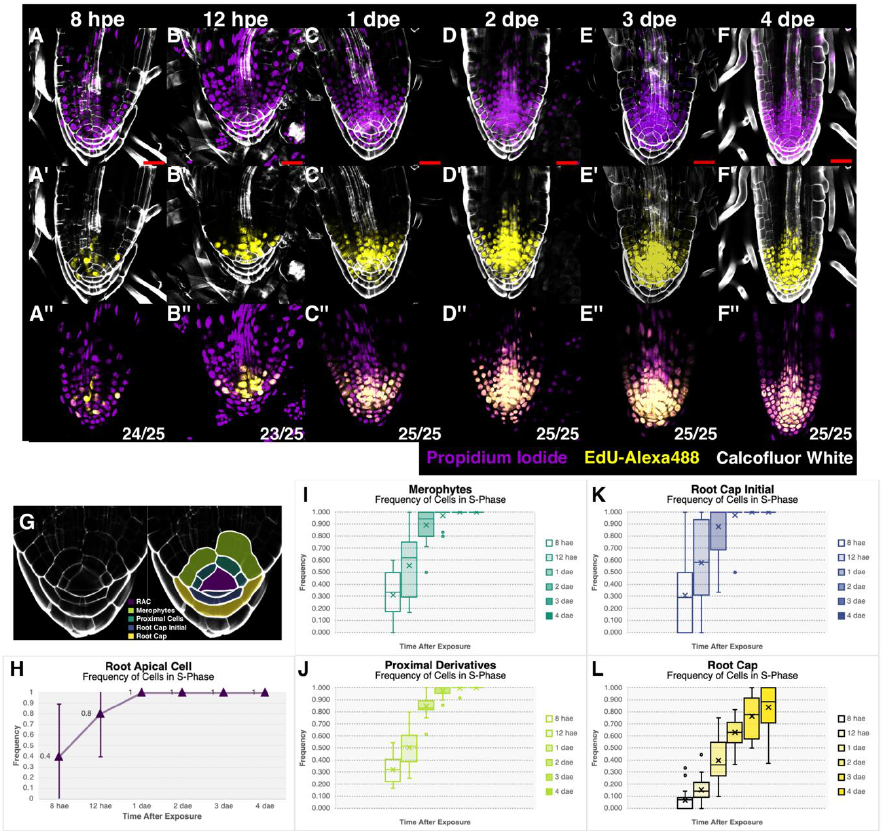
Figure 6. Cellular dynamics of the first shoot-borne root. ( A – F ) EdU incorporation experiment to detect cells in their S-phase of cell cycle at 8 hae ( A , A’ , A’’ ), 12 hae ( B , B’ , B’’ ), 1 dae ( C , C’ , C’’ ), 2 dae ( D , D’ , D’’ ), 3 dae ( E , E’ , E’’ ), and 4 dae ( F , F’ , F’’ ). (A to F) DNA counterstaining and cell wall staining (Propidium Iodide—Purple; Calcofluor White—White); ( A’ – F’ ) EdU-labeled DNA and cell wall staining (EdU-Alexa488—Yellow; Calcofluor White—White); ( A’’ – F’’ ) EdU-labeled DNA and DNA counterstaining merge (EdU-Alexa488—Yellow; Propidium Iodide—Purple). Scale bar: 20 μm. hae—hours after exposure; dae—days after exposure. Numbers in the right bottom corner of Figure 6A”–F”: Amount of plants displaying the triple staining / Total amount of plants used in the experiment ( G ) Established zonation inside the stem cell niche. The following plots represent the average frequency of cells entering the S-phase of the cell cycle in a specific zone of Ceratopteris root apical meristem at di ff erent times of EdU incorporation: ( H ) Scattered plot of the frequency of S-phase cells in the RAC. ( I – L ) Box plots showing the frequency of entering the S-phase of cell cycle in the di ff erent zones of the RAM: merophytes ( I ); proximal cells ( J ); root cap initials ( K ); root cap cells ( L ). The frequency of cells entering to S-phase was statistically determined with a student’s t test for each cell type. Note: brightness of the Alexa-488 channel in Figure 6F” was decreased when compared to previous times in order to have a better observation of both merged